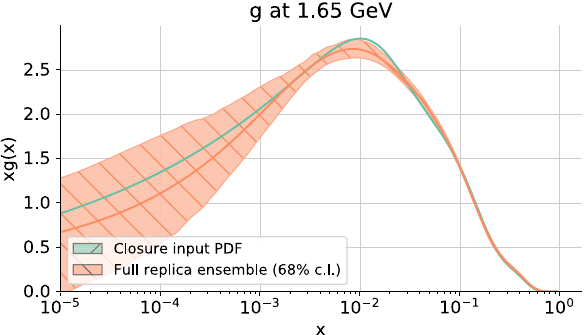
Fig. 4 The green line is the input underlying law for the gluon PDF, which is sampled from the ensemble of replicas from a fit to data. The central value and the 68% confidence interval for those replicas are plotted as the orange line and band